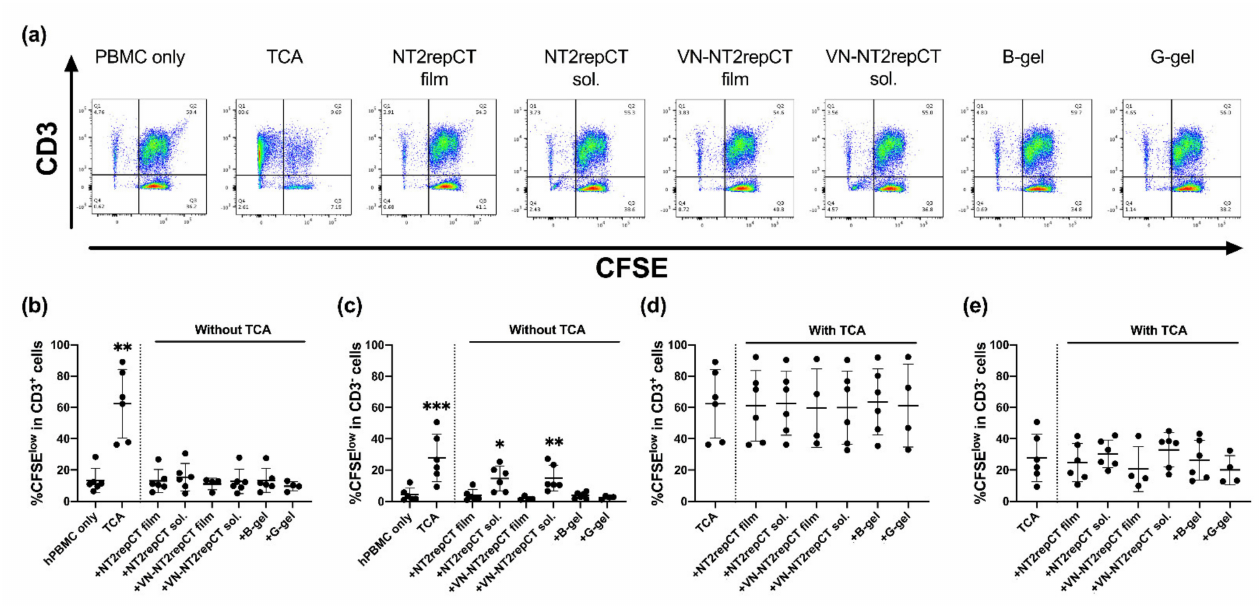
Figure 3. Proliferation of hPBMCs after exposure to different biomaterials for 5 d. ( a ) Representative flow cytometry data of the hPBMCs CFSE fluorescence intensity and frequency of CD3 expression. Percentages (%) of proliferated CFSE low cells out of the total number of ( b ) CD3 + cells or ( c ) CD3 − cells in the groups, including: hPBMC, only (baseline control); (hPBMCs) + TCA (positive control); (hPBMCs) + NT2RepCT film; (hPBMCs) + soluble NT2RepCT; (hPBMCs) + VN– NT2RepCT film; (hPBMCs) + soluble VN–NT2RepCT; (hPBMCs) + bulk HA hydrogel (“B-gel”) or (hPBMCs) + granular HA hydrogel (“G-gel”) were examined. The percentages (%) of proliferated CFSE low cells among the total number of ( d ) CD3 + cells or ( e ) CD3 − cells after TCA treatment in all the experimental groups was also examined. Data are presented as mean ± SD. The vertical dotted line in the graph demarcates the control versus the experimental groups. The statistical test of mixed-effects analysis with Dunnett’s post hoc test was applied after log-transformation in order to compare the experimental groups with the respective control group. Statistically significant differences from the control hPBMCs-only group ( b , c ) or from the TCA group ( d,e ) are indicated as: * p ≤ 0.05, ** p ≤ 0.01, *** p ≤ 0.001. n = 4–6 biologically different hPBMC populations. Abbreviations: SD, standard deviation; TCA, T cell activation; sol., soluble; B-gel, bulk HA hydrogel; G-gel, granular HA